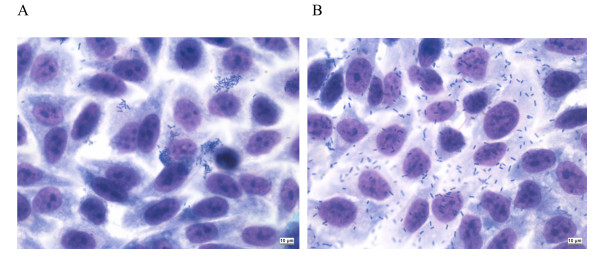
Light micrographs of E. sakazakii strain ES3 adhering in clusters (A) and strain ES6 showing diffuse adherence to HEp-2 cells (B). Methanol fixed and Giemsa stained.